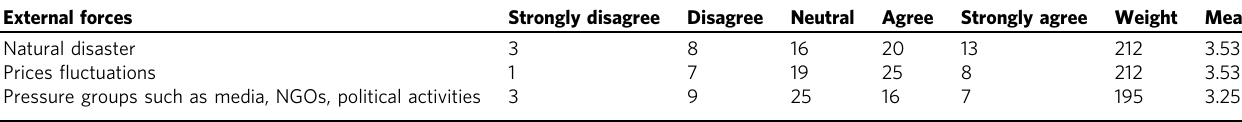
Table 6 Causes of project failure from external forces ( N = 60).